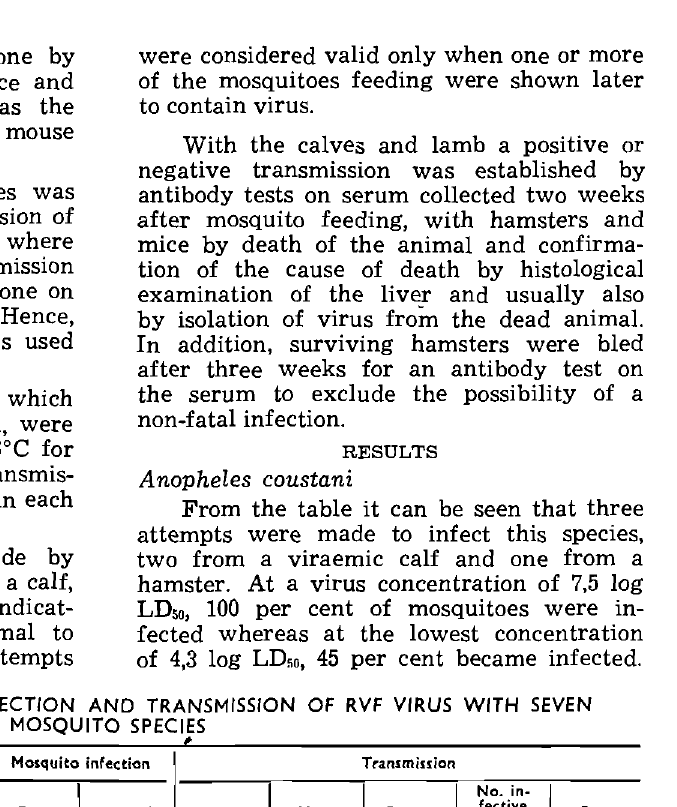
Table: RESULTS OF ATTEMPTED INFECTION AND TRANSMISSION OF RVF VIRUS WITH SEVEN MOSQUITO SPECIES ~ Virus Mosquito infection Transmiuion Viraemic Species